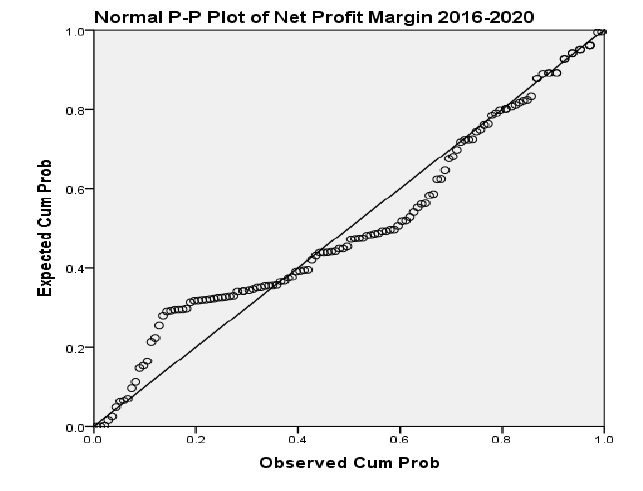
Figure 2 : Normality test pp